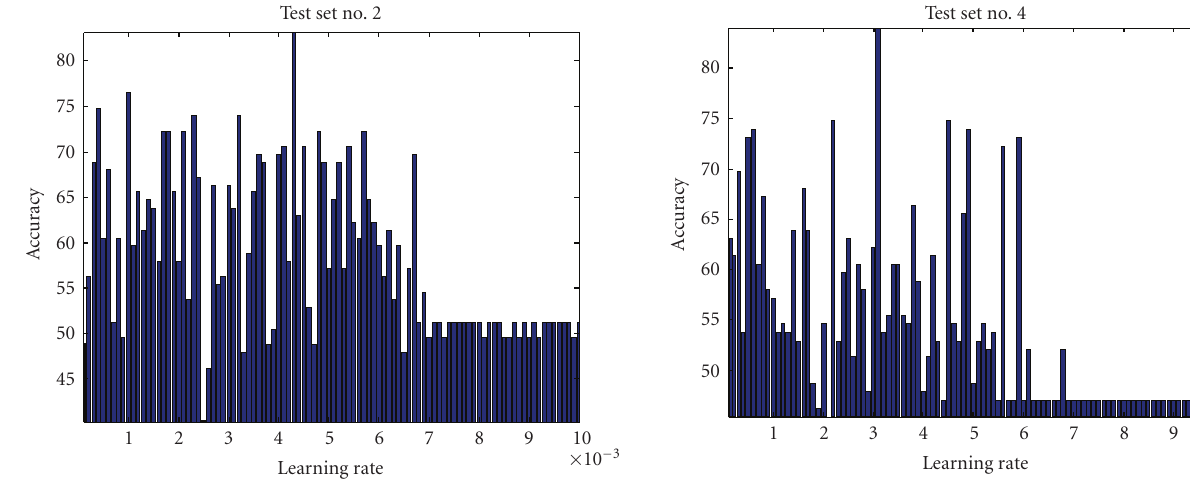
Figure 7: Learning rate impact on accuracy for test set number 4 (all other parameters were kept at constant values).